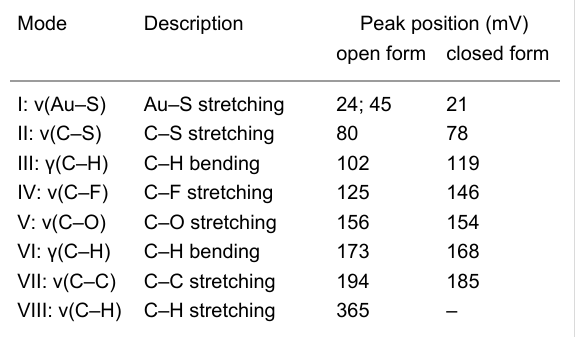
Table 1: Approximate vibrational mode assignment for the theoretical- ly computed IET spectra of Au-C5F-ThM-Au molecular